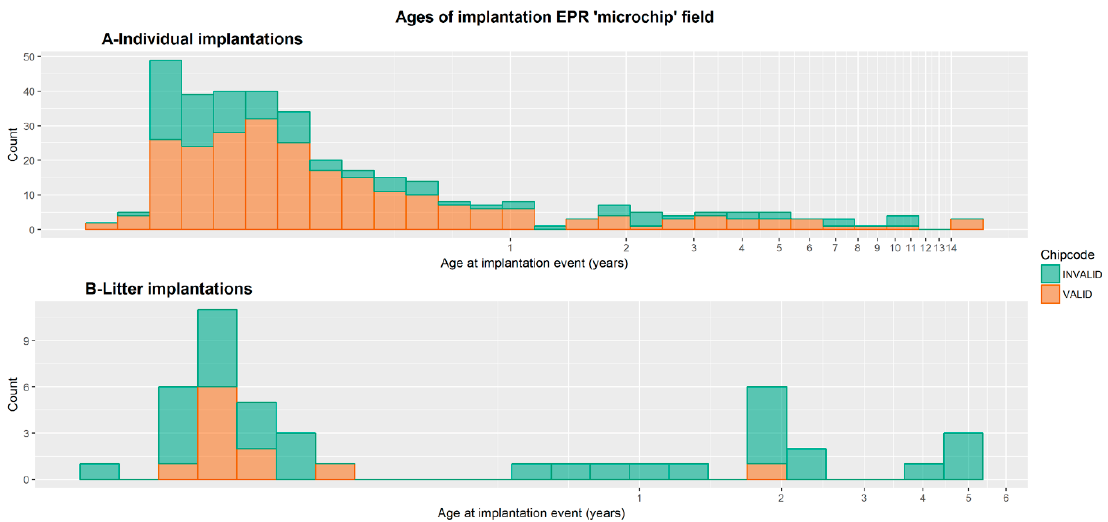
Figure 1. A and B: Showing the apparent age at microchip implantation for animals with both valid and invalid microchip fields in the electronic patient records (EPRs) for ( A ) individuals and ( B ) litters. Orange portion of bars = electronic patient records with a valid microchip field, green portion of bars = EPRs with an invalid microchip field. Age for litter vaccination would be the dam’s age if the implantation event was recorded within her EPR.